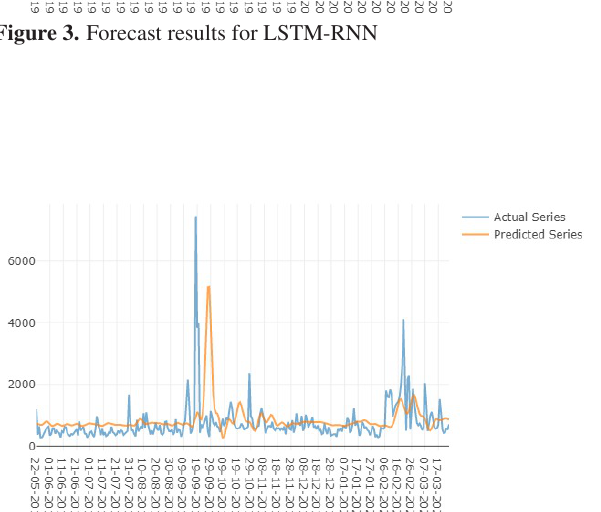
Figure 3. Forecast results for LSTM-RNN